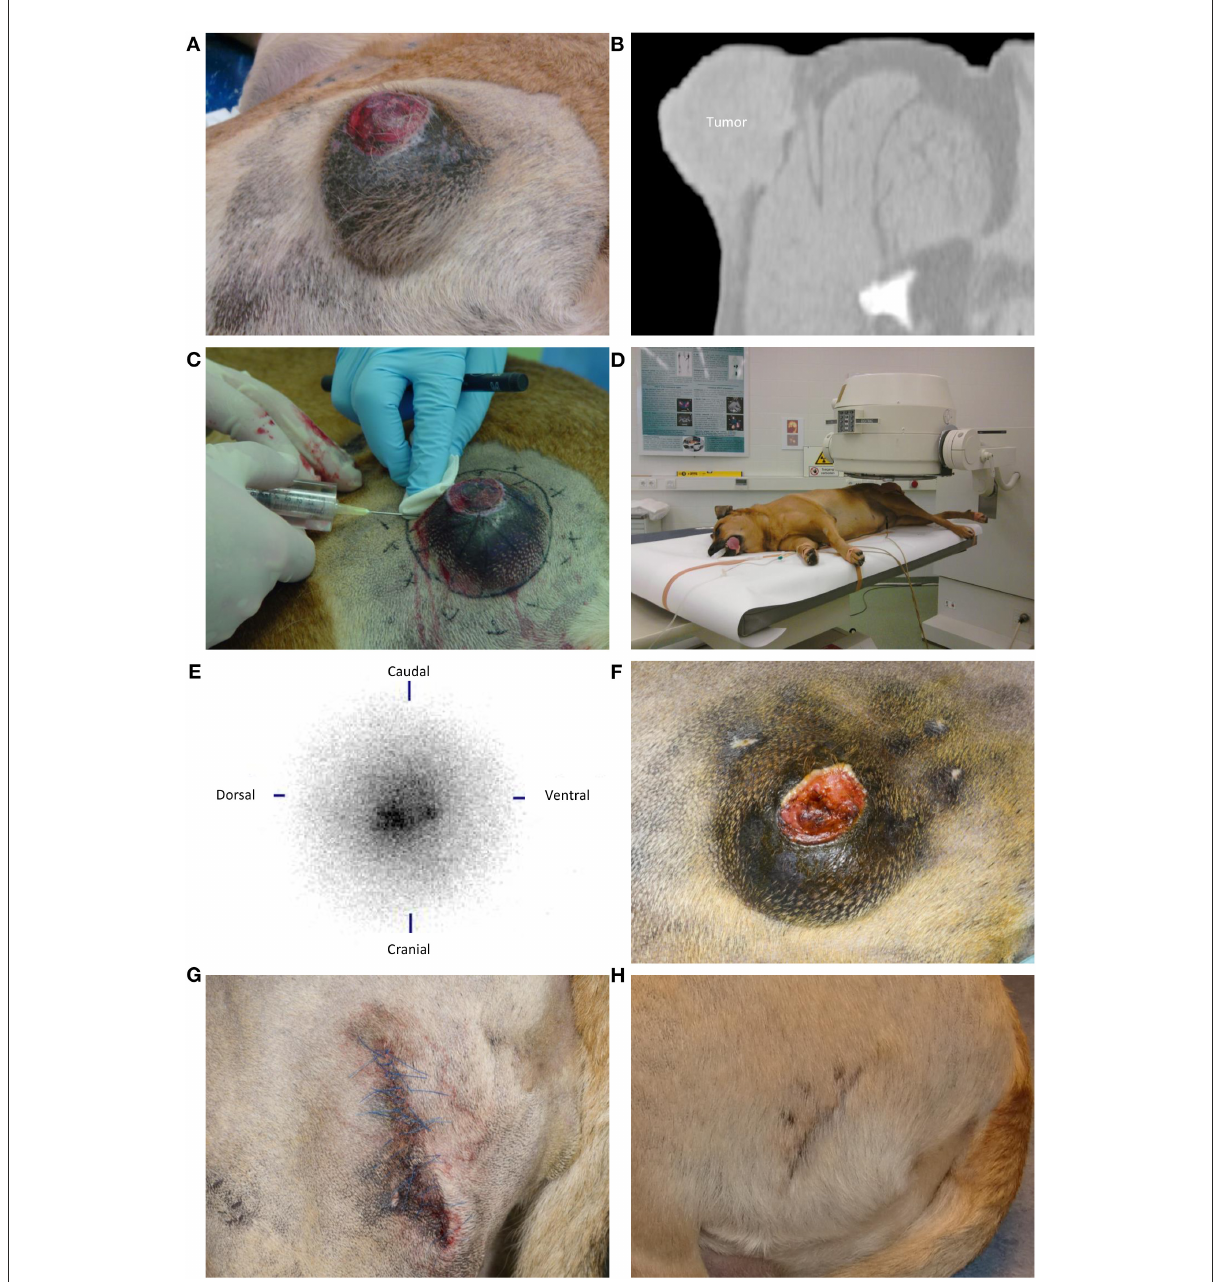
FIGURE2 Intratumoral holmium-166 microsphere ( 166 HoMS) treatment and follow-up of patient 3 with a soft tissue sarcoma in the left proximal femur. (A) The tumor seven days before treatment, showing an ulcerative lesion of 1.5 × 1.5cm in the center of the tumor. (B) Computed Tomography of the tumor seven days before treatment, showing a transverse slice with evident infiltration of the tumor into subcutaneous tissues. (C) Needle-injection of 166 HoMS in 12 predetermined and marked tumor segments. An 8-mm thick acrylic glass cylinder was placed around the syringe to limit beta radiation exposure of personnel and the patient. (D) Left lateral planar gamma scintigraphy of the tumor after treatment. (E) Left lateral planar gamma scintigraphy image of the tumor after treatment, showing concentrated gamma counts in the tumor area (center). (F) The tumor 36 days after treatment, showing an 82% decrease in tumor volume compared to Figure 2A, with still an ulcerative lesion in the tumor center. (G) The patient’s hip after surgical resection of the tumor, 36 days after 166 HoMS treatment. (H) The patient’s hip 63 days after 166 HoMS treatment and 27 days after surgical